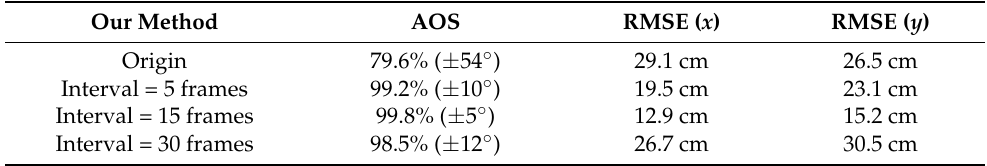
Figure 15. Results for error correction according to intervals of five, 15, and 30 frames with origin trajectory: ( a ) straight (left and right); ( b ) straight (down and up); ( c ) left turn; ( d ) U turn. Table 3. Quantitative difference between ground-truth data and 3D vehicle trajectory extracted using proposed